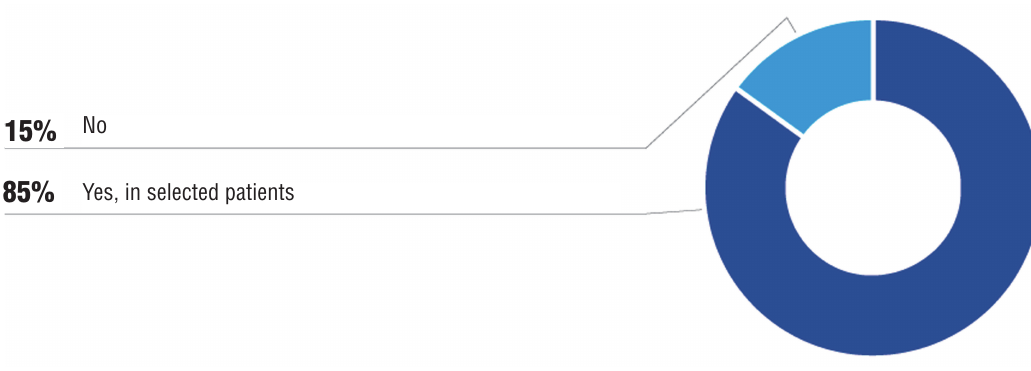
figure 4 - In an environment without any restrict access to other therapeutic options, is there indication of re-treatment with